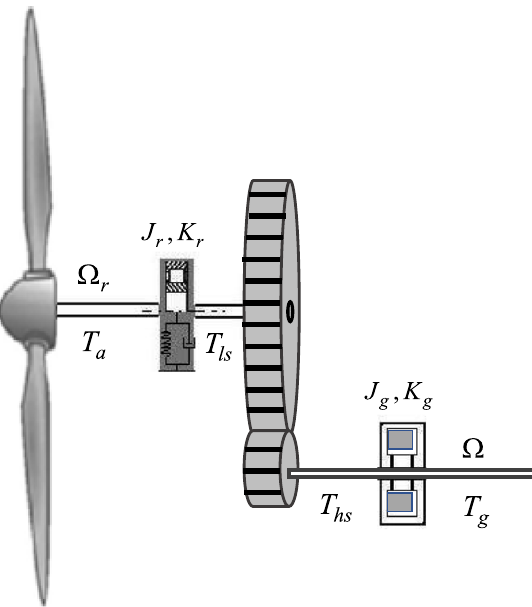
Fig. 1 WECS configuration based on DFIG